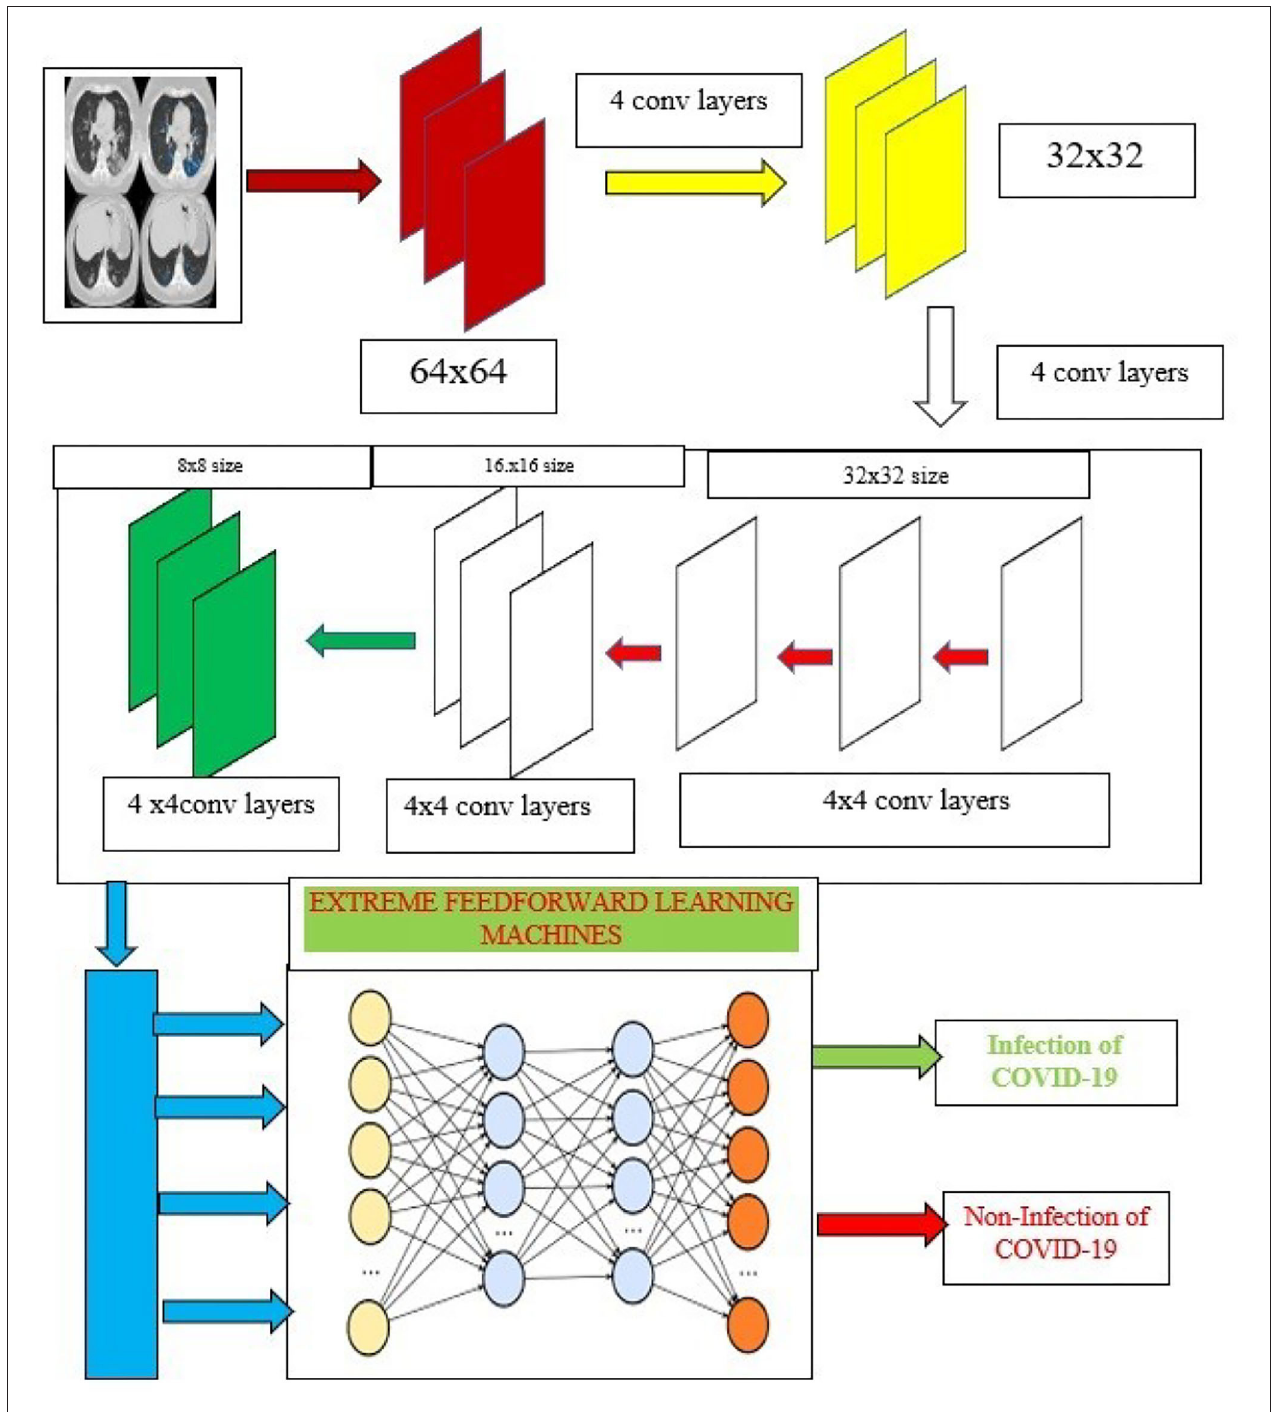
FIGURE 4 | Capsule ensembled ELM layers for achieving the feature extraction and classification accuracy.